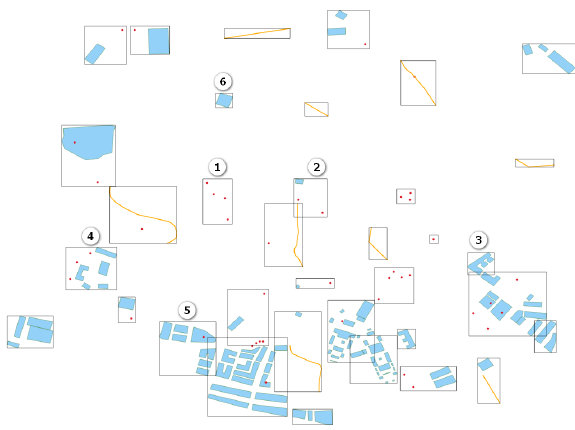
Figure 6 . Bounding box of clusters.